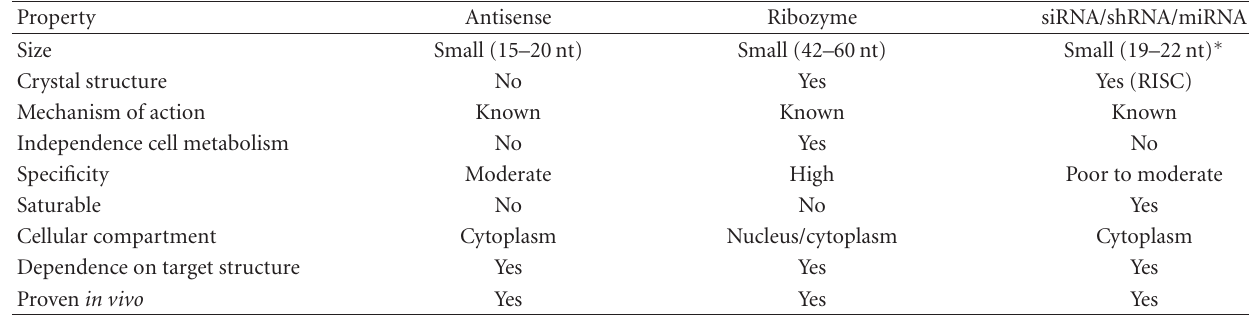
Table 1: Comparison of the properties of antisense, ribozyme, and RNA i .